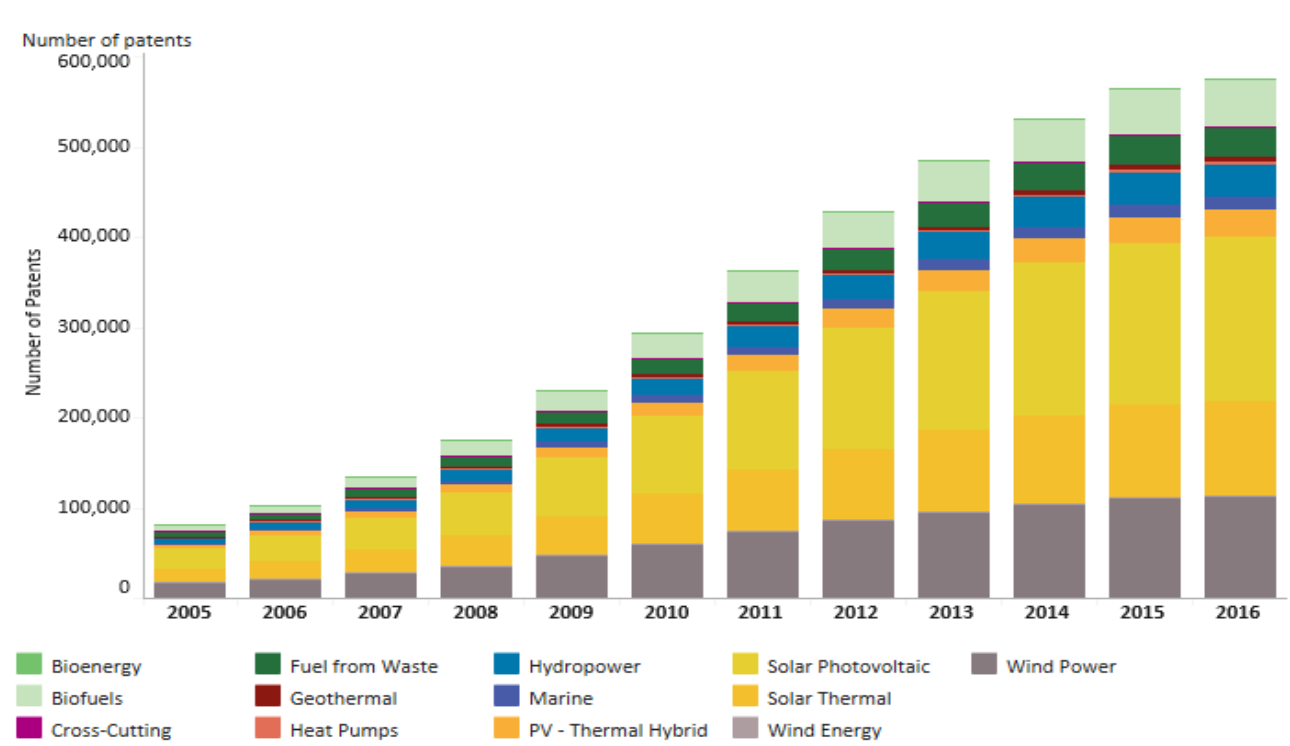
Figure 2. Renewable energy patent evolution. Source: IRENA INSPIRE [9], based on data from EPO PATSTAT and the climate change technologies classification of EPO.